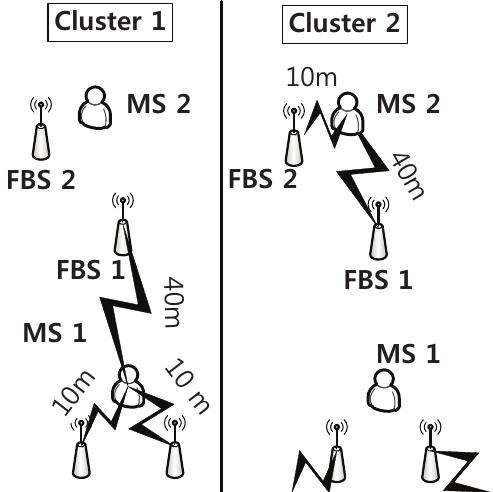
Figure 1. Toy example that depicts the limitation of conventional on–off power control